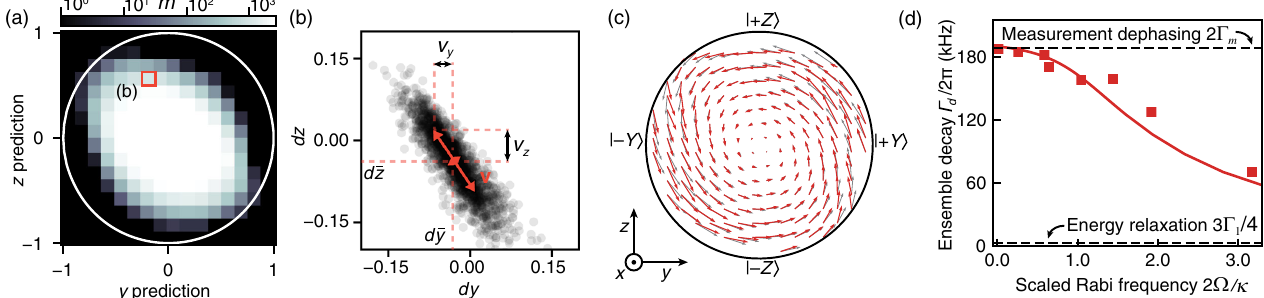
FIG. 3. LSTM trajectory processing and unraveling Lindbladian trajectory dynamics. (a) Histogram of the LSTM trajectories in the yz plane of the Bloch sphere for 2 Ω = κ ¼ 0 . 6 . To extract trajectory drift and diffusion, we perform statistics on the Bloch vector increments , where m is the number of samples in each bin; see color bar. (b) Statistics of the Bloch vector increments for the fð dy k ; dz k Þg m k ¼ 0 highlighted pixel in (a). The mean of the Bloch vector increments gives the average drift ( d ¯ y; d ¯ z ), whereas the scaled eigenvector of the covariance matrix ( v ) gives the direction and magnitude of stochastic kicks due to measurement backaction. We compute ( d ¯ y; d ¯ z ) and v for each pixel in the yz plane to visualize the Lindbladian dynamics and measurement backaction. (c) The average drift ð d ¯ y; d ¯ z Þ of trajectories binned in the yz plane ( 2 Ω = κ ¼ 0 . 6 , red arrows) reveals dynamics consistent with the applied Hamiltonian H ¼ Ω σ decay toward y ¼ 0 at a rate Γ . The gray arrows represent a fit of the extracted pairs ð d ¯ y; d ¯ z Þ to Eqs. (6) and (7), with Ω and Γ d = 2 π (red squares) falls from the expected measurement dephasing rate 2 Γ parameters. (d) The decay rate Γ d relaxation rate [45], as the qubit and resonator decouple. A master equation simulation of the qubit-resonator system (solid line) agrees qualitatively with the LSTM